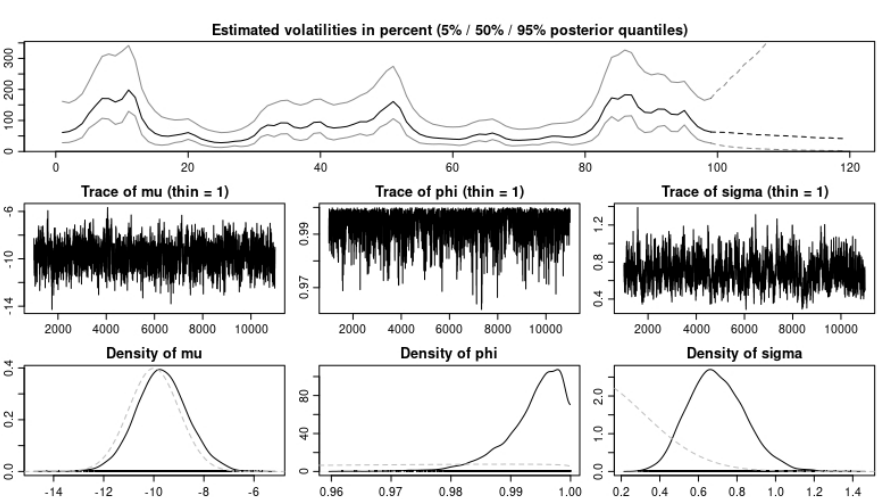
Figure 2. Graph showing estimated volatility for eruption